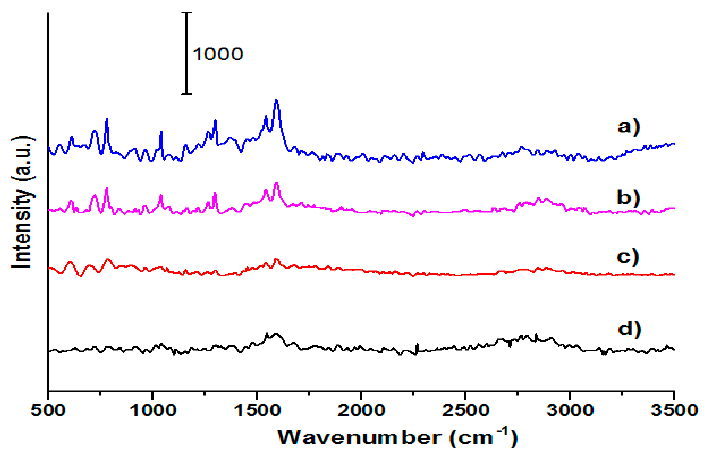
Figure 7. Raman spectra of di ff erent concentrations of thiophanate methyl: ( a ) 7 mg / L, ( b ) 5 mg / L, ( c ) 3 mg / L, and ( d ) 1 mg / L recorded on AuNR-coated glass